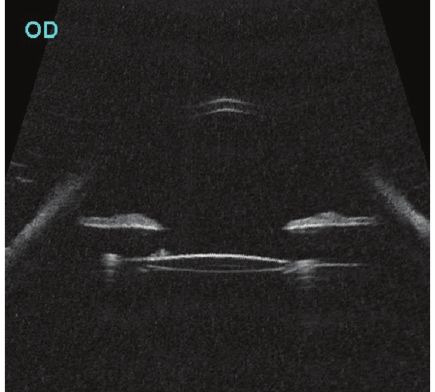
Figure 4: Ultrasound biomicroscopy (axial scan) of the right eye after cataract surgery showing resolution of posterior bowing of midperipheral iris and well-centered intraocular lens with gap between lens and